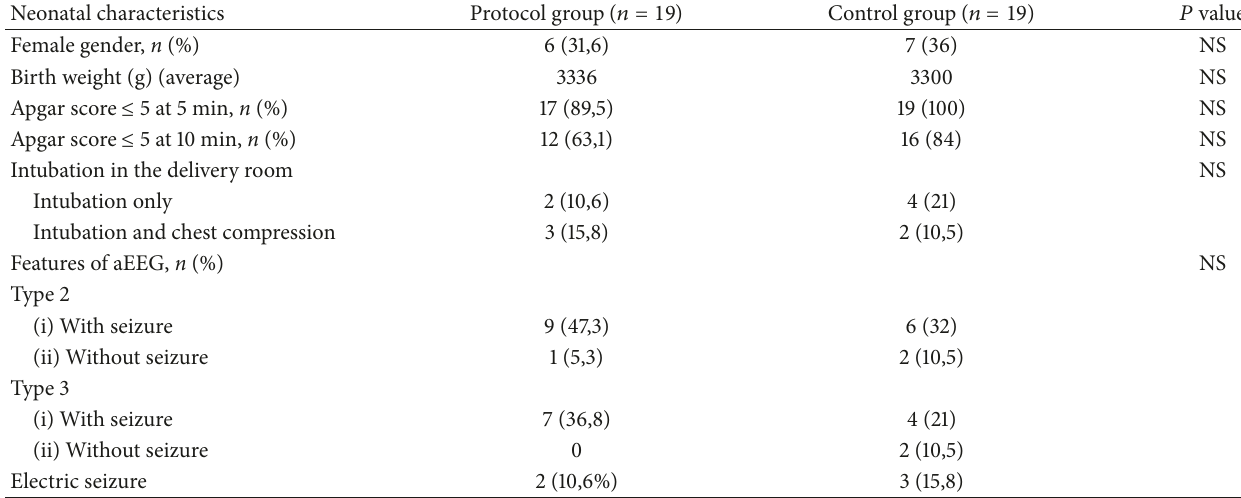
Table 2: Neonatal